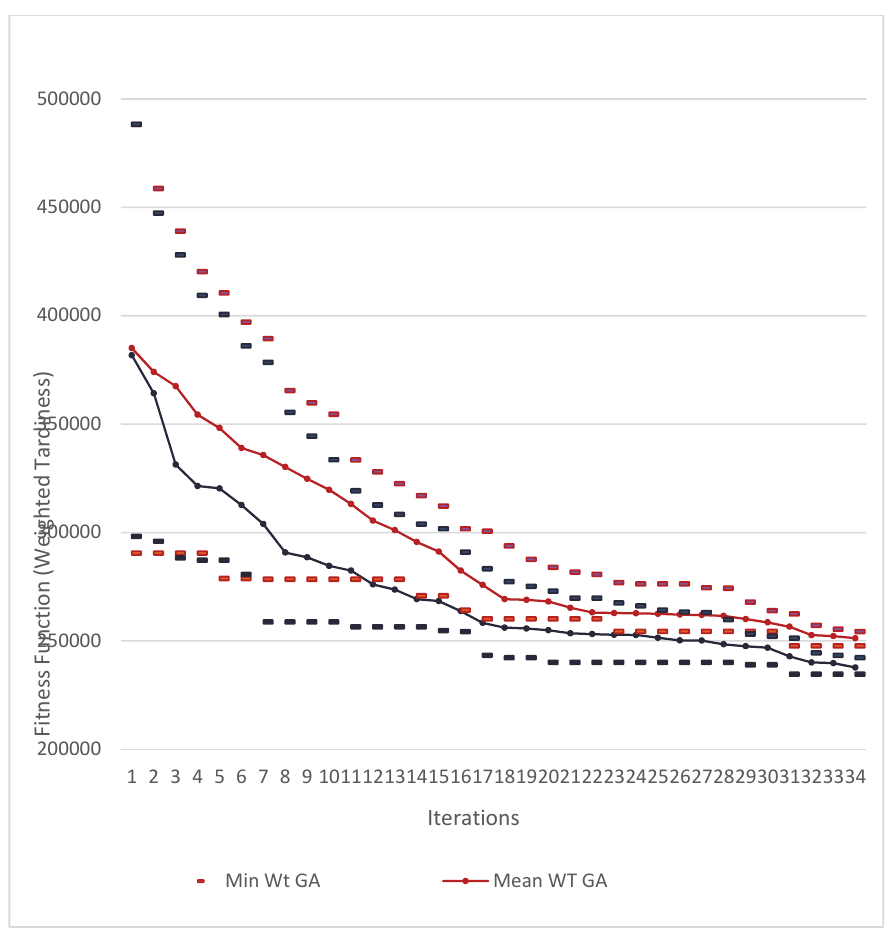
Fig. 1. Evolution of reschedule by traditional GA and AGA